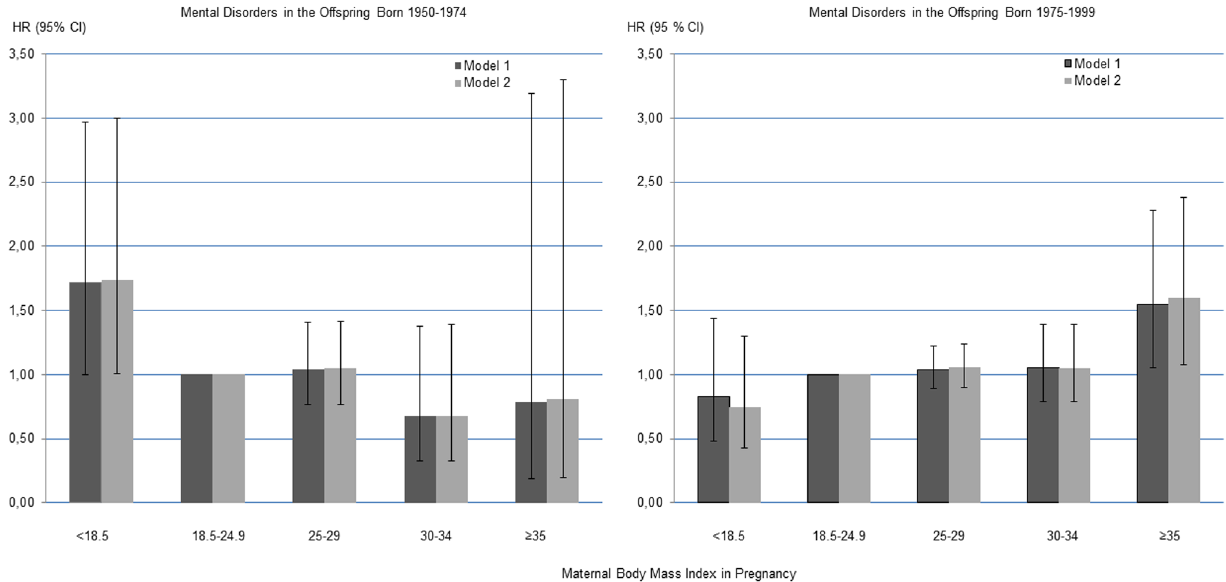
Figure 1. Maternal Body Mass Index in Pregnancy and Mental Disorders in the Offspring Born 1950–1974 and 1975–1999. Hazard Ratios (HR) and 95% Confidence Intervals (CI) from Cox Proportional Hazards Models adjusted for child sex and birth year and gestation at maternal weight measurement (Model 1) and additionally for maternal smoking and hypertensive disorders in pregnancy, maternal mental disorders, age, parity and social class of the